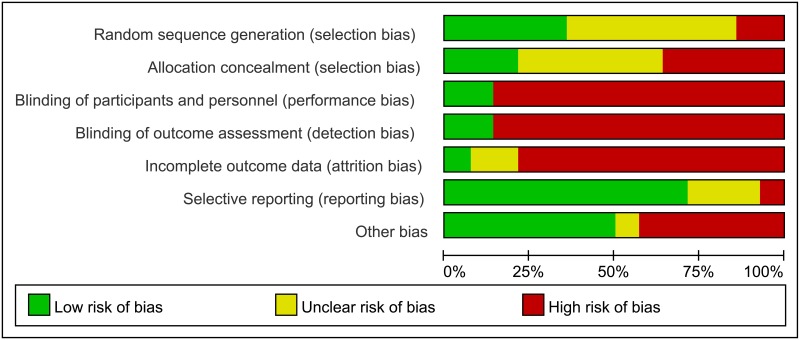
Risk of bias graph of included RCTs.